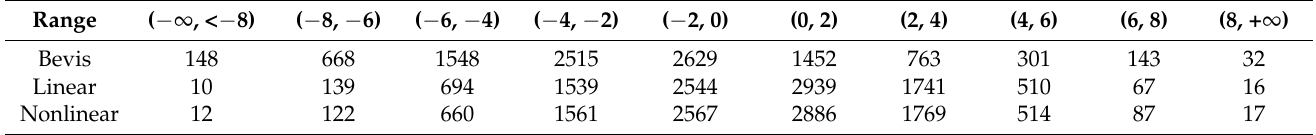
Table 11. Deviation statistics of Bevis model, linear and nonlinear seasonal three-factor RTMs in the Yangtze River Delta region during 2016-2017 (K).